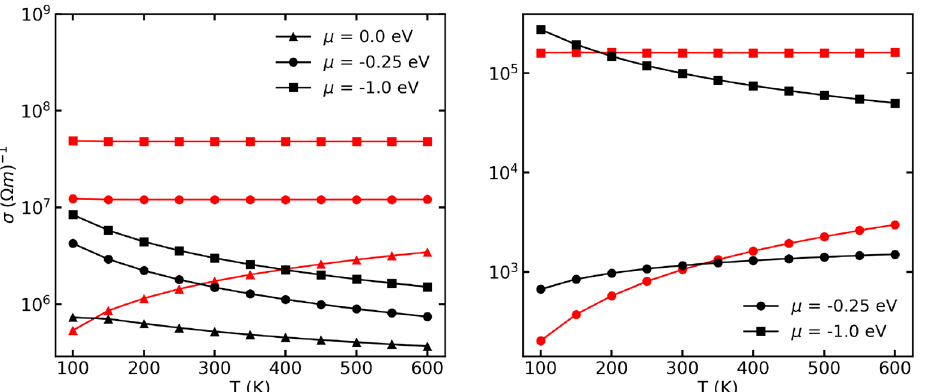
Figure 3. Electronic conductivity as a function of temperature at various chemical potentials (representing the doping level, referred to the middle of the gap). The left panel corresponds to graphene (with zero band gap) and the right panel corresponds to cubium with a band gap of 0.5 eV. The red lines denote the conductivity calculated using the CRTA whereas the black lines correspond to the conductivity calculated using the RTA; different markers correspond to different chemical potentials as in the